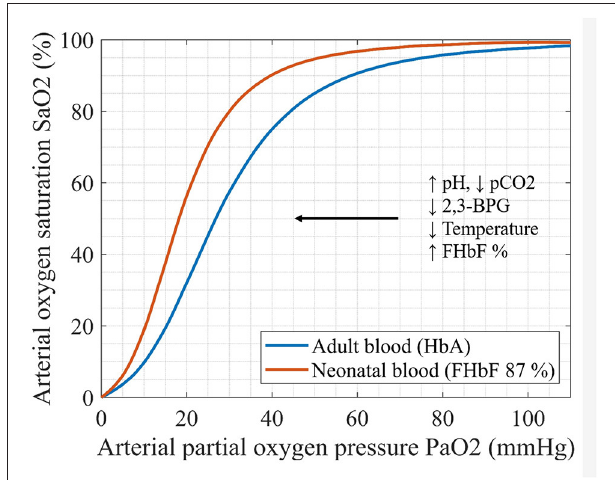
FIGURE 1 | Oxyhemoglobin dissociation curves (ODC) of adult and neonatal blood sample: ODC reflects the relationship between paO2 and SaO2. The factors that change the oxygen affinity for hemoglobin are illustrated (pCO2-partial pressure of carbon dioxid, 2,3-BPG- biphosphoglycerate, FHbF-fraction of fetal